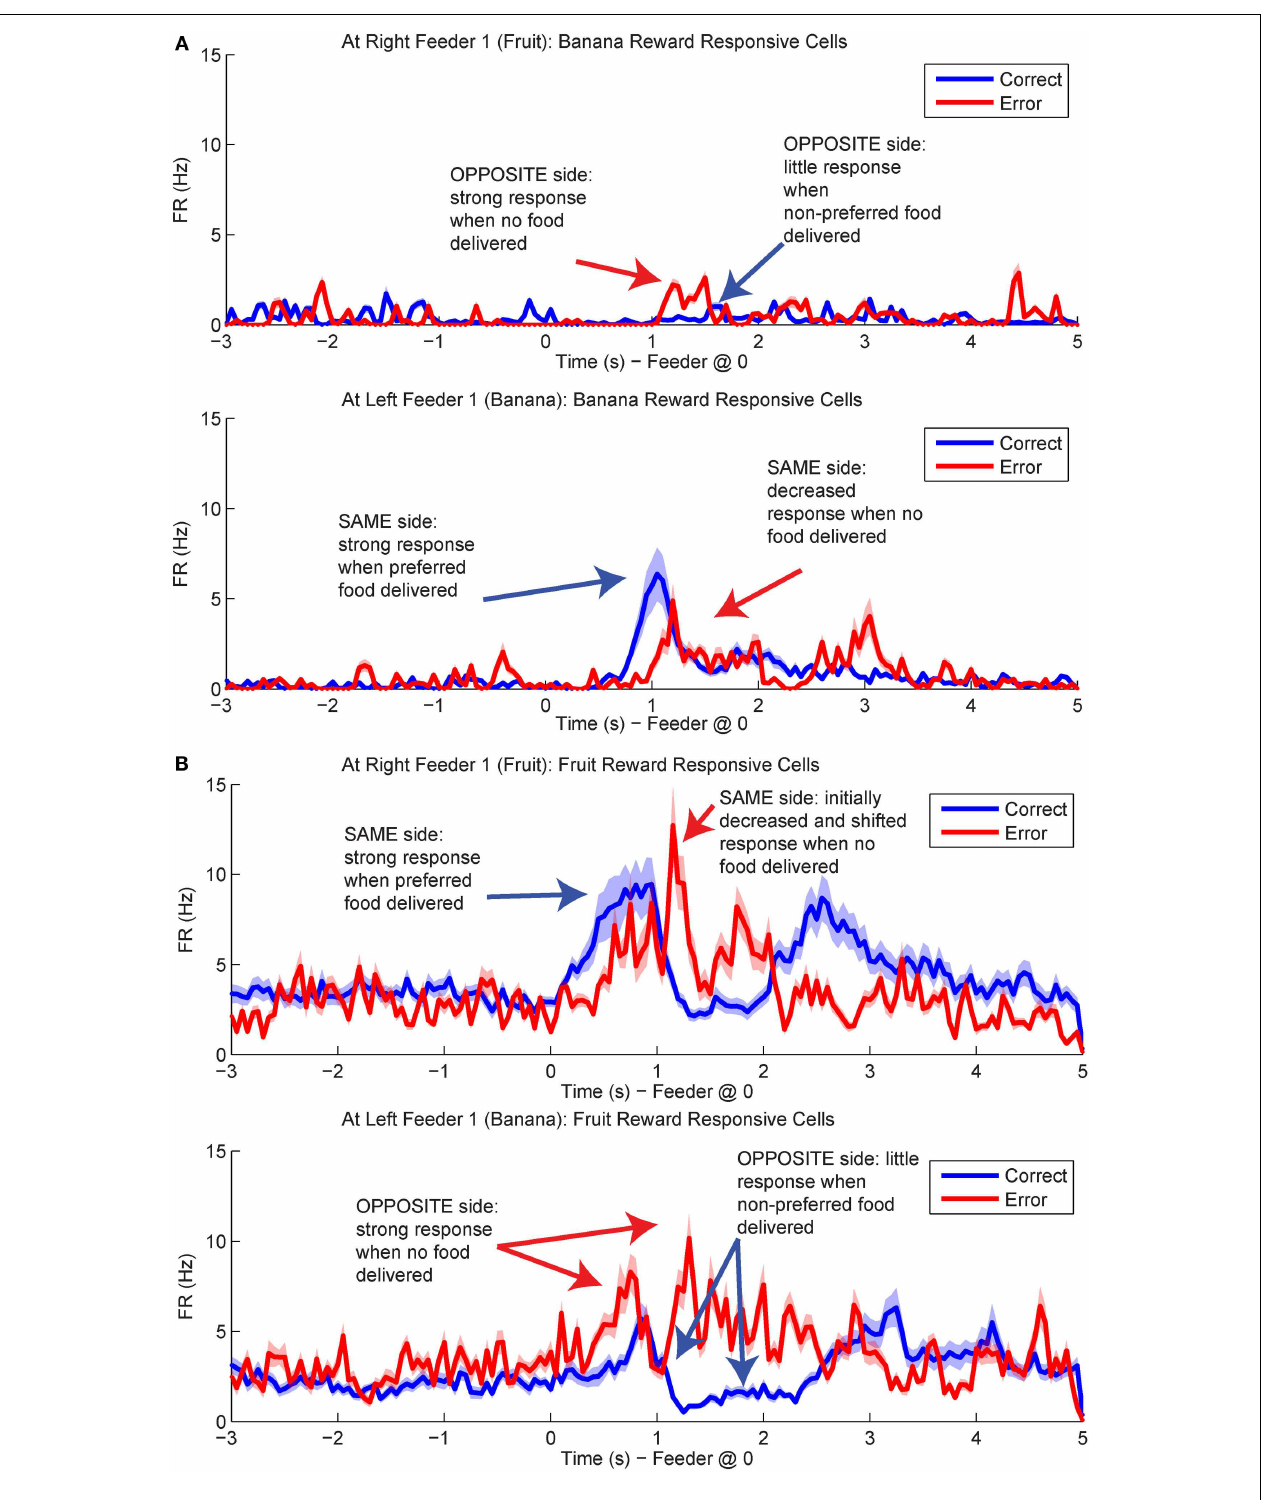
correct laps at the right feeder. (B) Right-reward/fruit preferring cells. Cells classified as right-reward preferring demonstrated increased firing at the right-reward sites.The blue line in the upper plot (correct at right feeder) is larger than the blue line in the lower plot (correct at left feeder). However, the activity of right-reward preferring cells is larger on error laps at the left feeder than on correct laps at the left feeder (red trace, lower